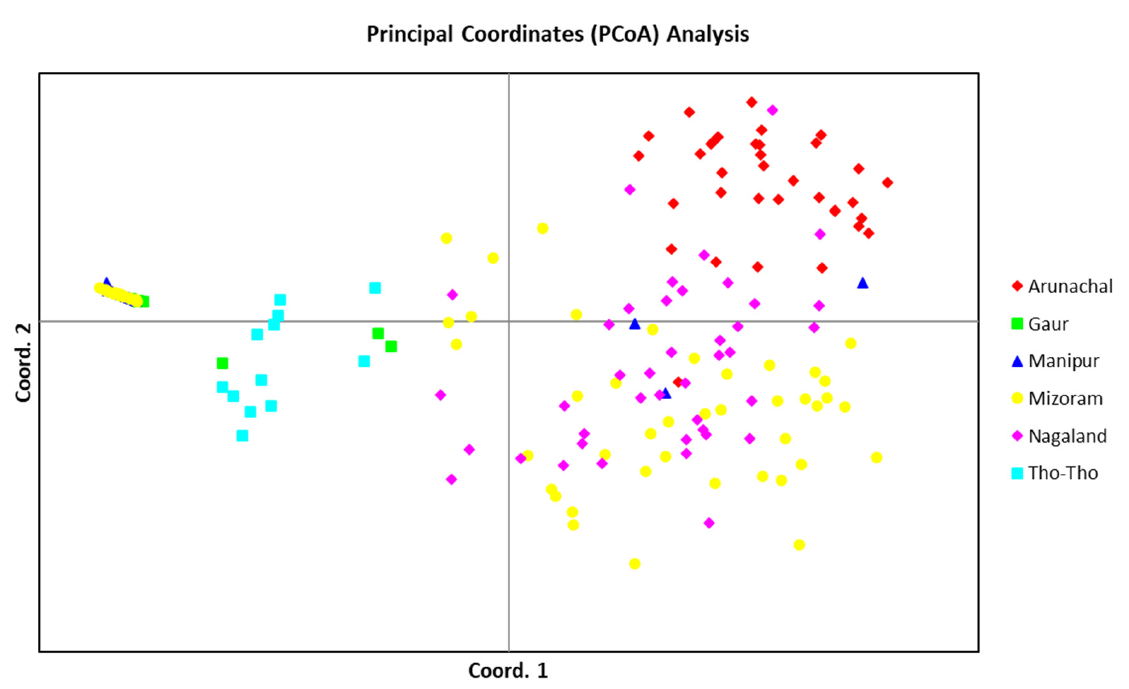
Figure 5. PCoA-based grouping of individuals belonging to different bovine populations of mithun, gaur, and Tho-tho with different color codings.